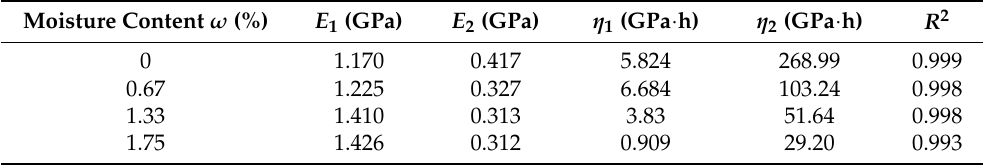
Table 1. Correspondence between moisture content and model parameters.